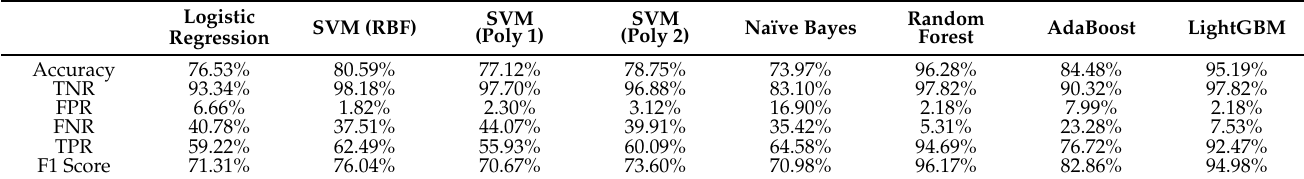
Table 4. Performance of the Evasion Classifiers.